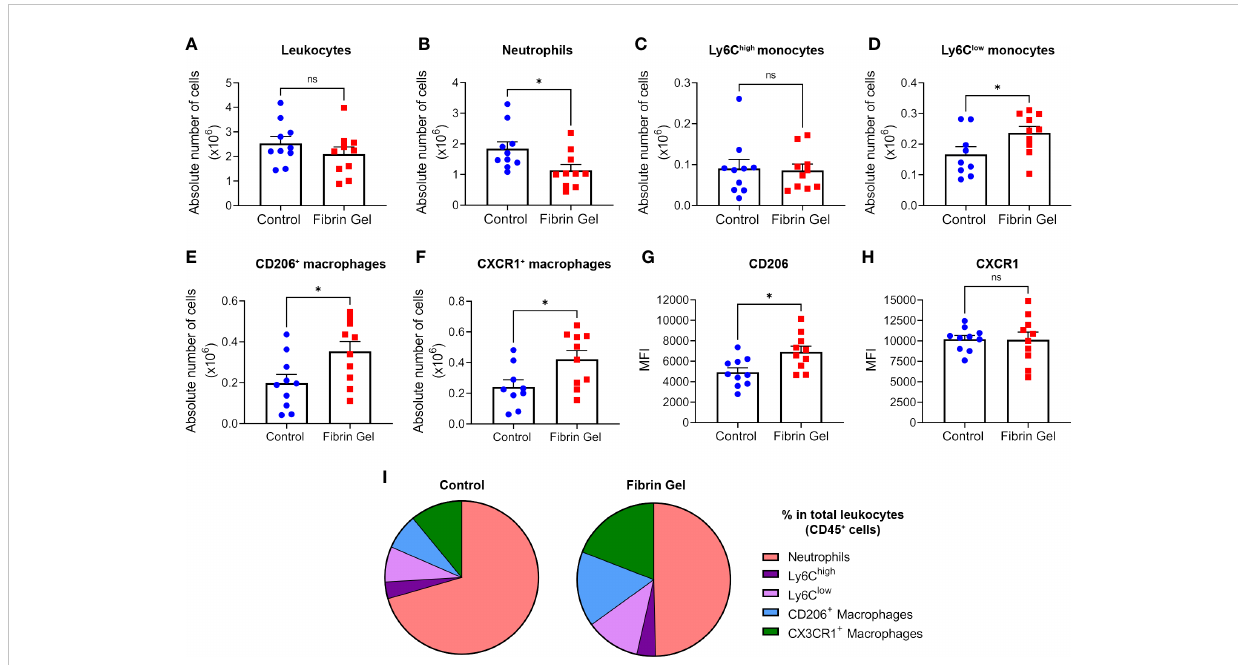
FIGURE 1 Effect of fi brin hydrogel on leukocyte subpopulations in skin wounds. Leukocyte in fi ltration was analyzed 3 days postinjury in wounds treated with fi brin hydrogel (Fibrin Gel) and in wounds left untreated (Control). (A) Absolute numbers of leukocytes (CD45 + ), (B) neutrophils (CD45 + , CD11b + and Ly6G + ), (C) monocytes Ly6C high (CD45 + , CD11b + , Ly6G - , Ly6C high ), (D) monocytes Ly6C low (CD45 + , CD11b + , Ly6G - , Ly6C low ), (E) macrophages CD206 + (CD45 + , CD11b + , Ly6G - , F4/80 + , CD206 + ) and (F) macrophages CX3CR1 + (CD45 + , CD11b + , Ly6G - , F4/80 + , CX3CR1 + ). Cell surface expression of CD206 (G) and CX3CR1 (H) in macrophages population (CD45 + , CD11b + , Ly6G - , F4/80 + ) was plotted as Mean Fluorescence Intensity (MFI). (I) Comparison of the percentages of leukocyte subpopulations (indicated in color codes) from the total leukocyte population. *p<0.05. Each symbol represents the data from a single mouse. Data are shown as mean ± SEM. ns, not signi fi